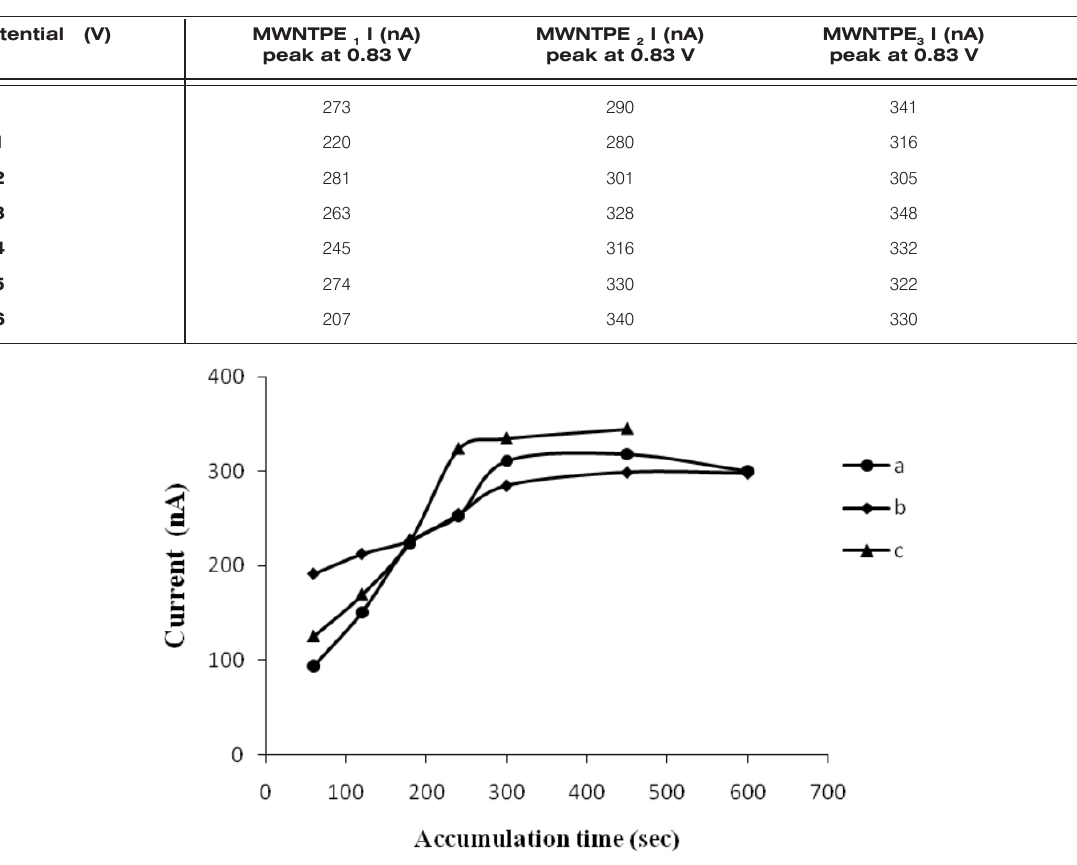
Figure 6. DPV signal of guanine versus accumulation time for 140 mg L -1 dsDNA at different electrodes: a) MWNTPE c)